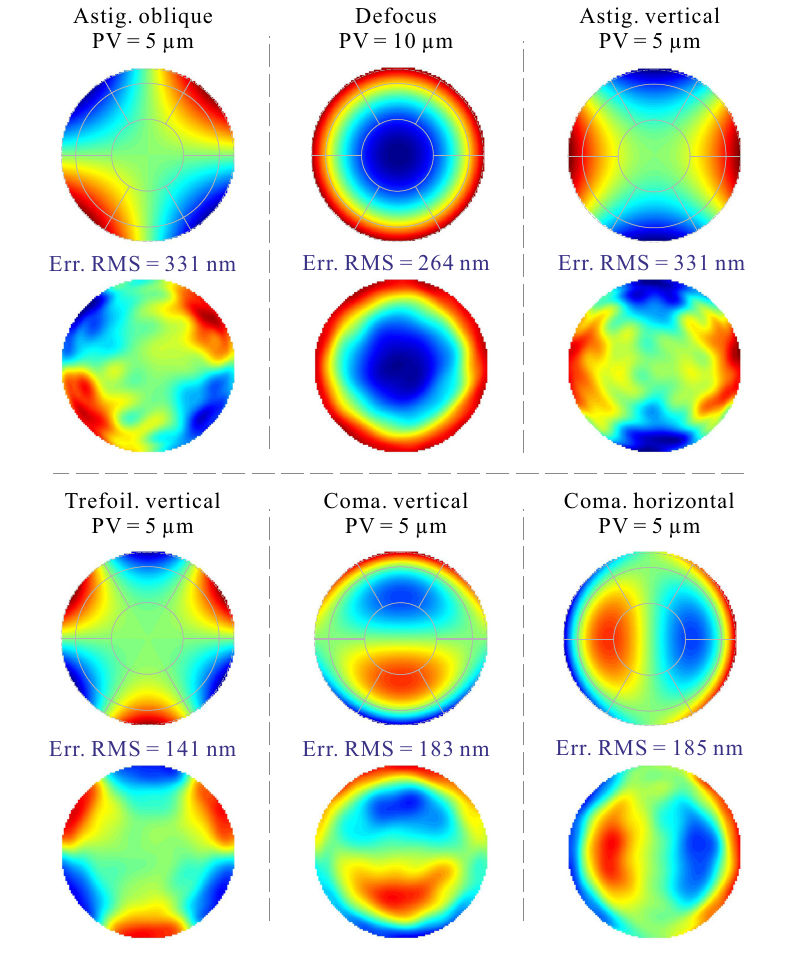
Figure 8. Six optical modes in a pupil of 120 mm. From top to bottom: Target, RMS fitting error, Reconstructed surface from the experimental influence